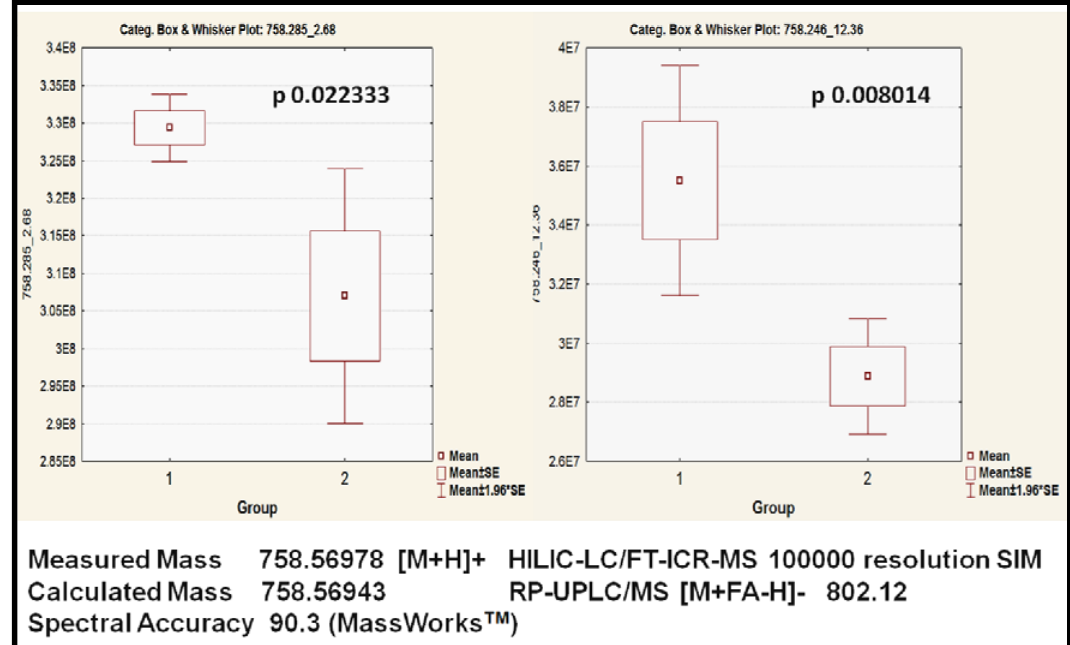
Figure 2. Box-Whisker plots of the potential classifiers at RT 2.68 min (left panel) and RT 12.36 min (right panel), which were later identified as PC (34:2) isomers.